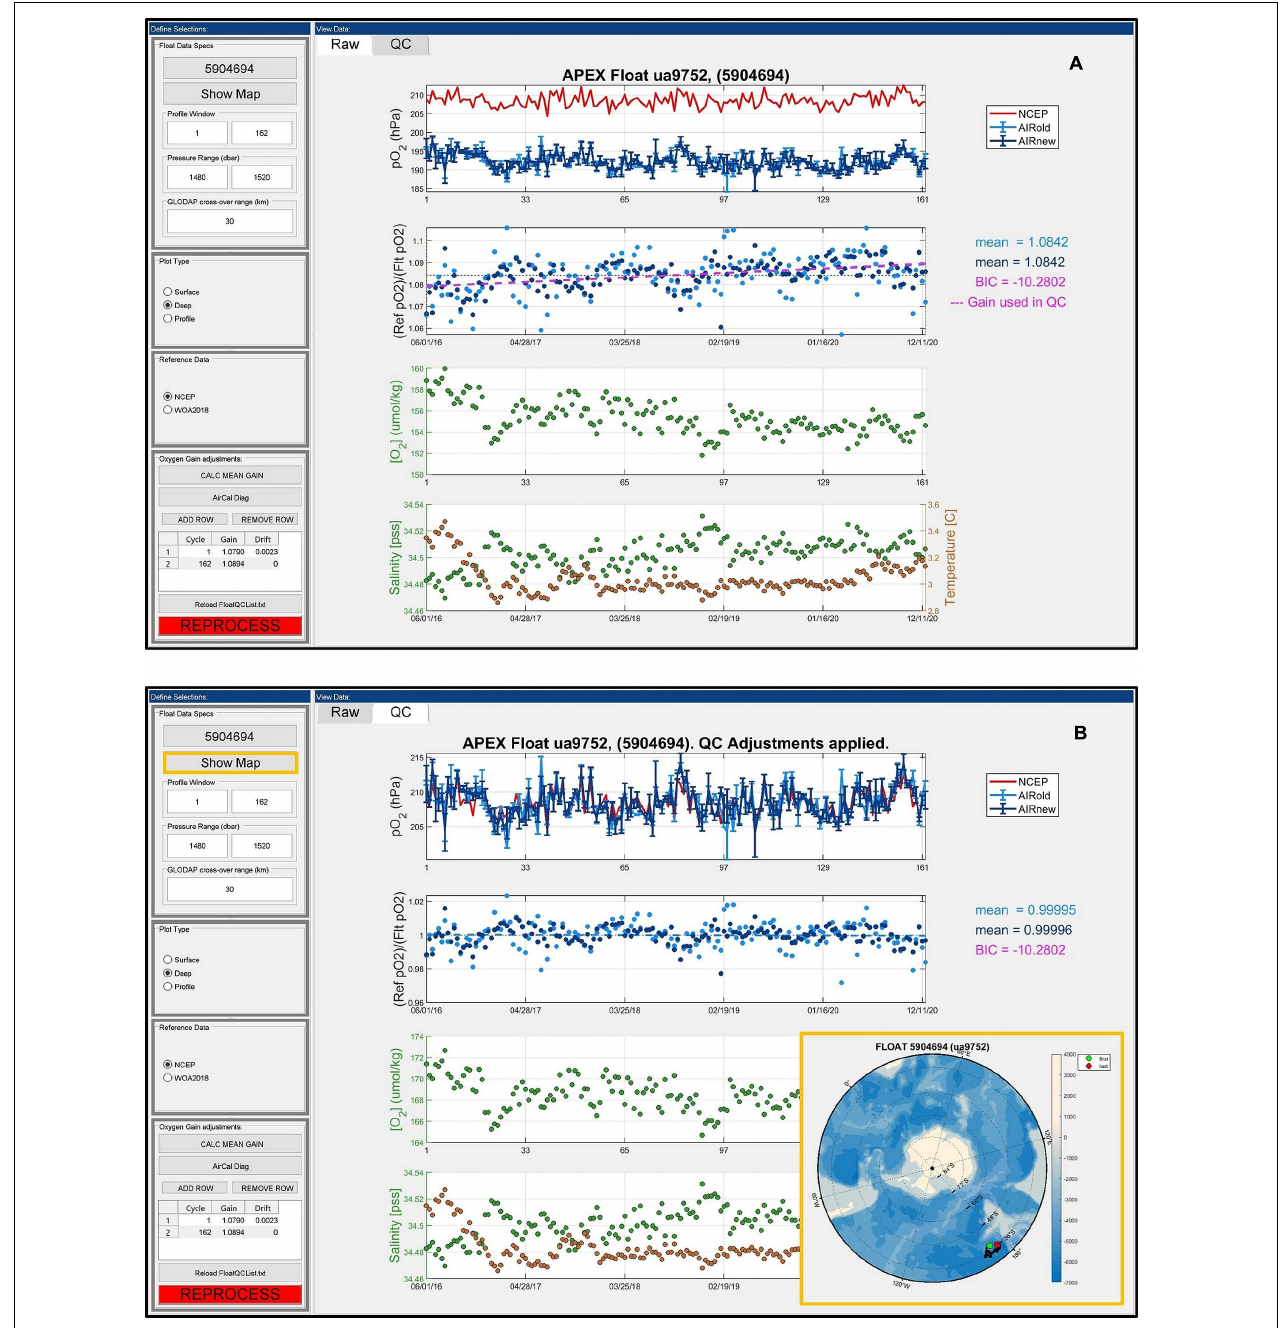
FIGURE 3 | SAGE-O 2 software interface showing results of the calibration for sample float 9752, WMO 5904694. The view in (A) displays the raw oxygen float data against the reference, while the view in (B) displays float data that was adjusted using the coefficients derived through the software. The map display functionality is also indicated in (B)